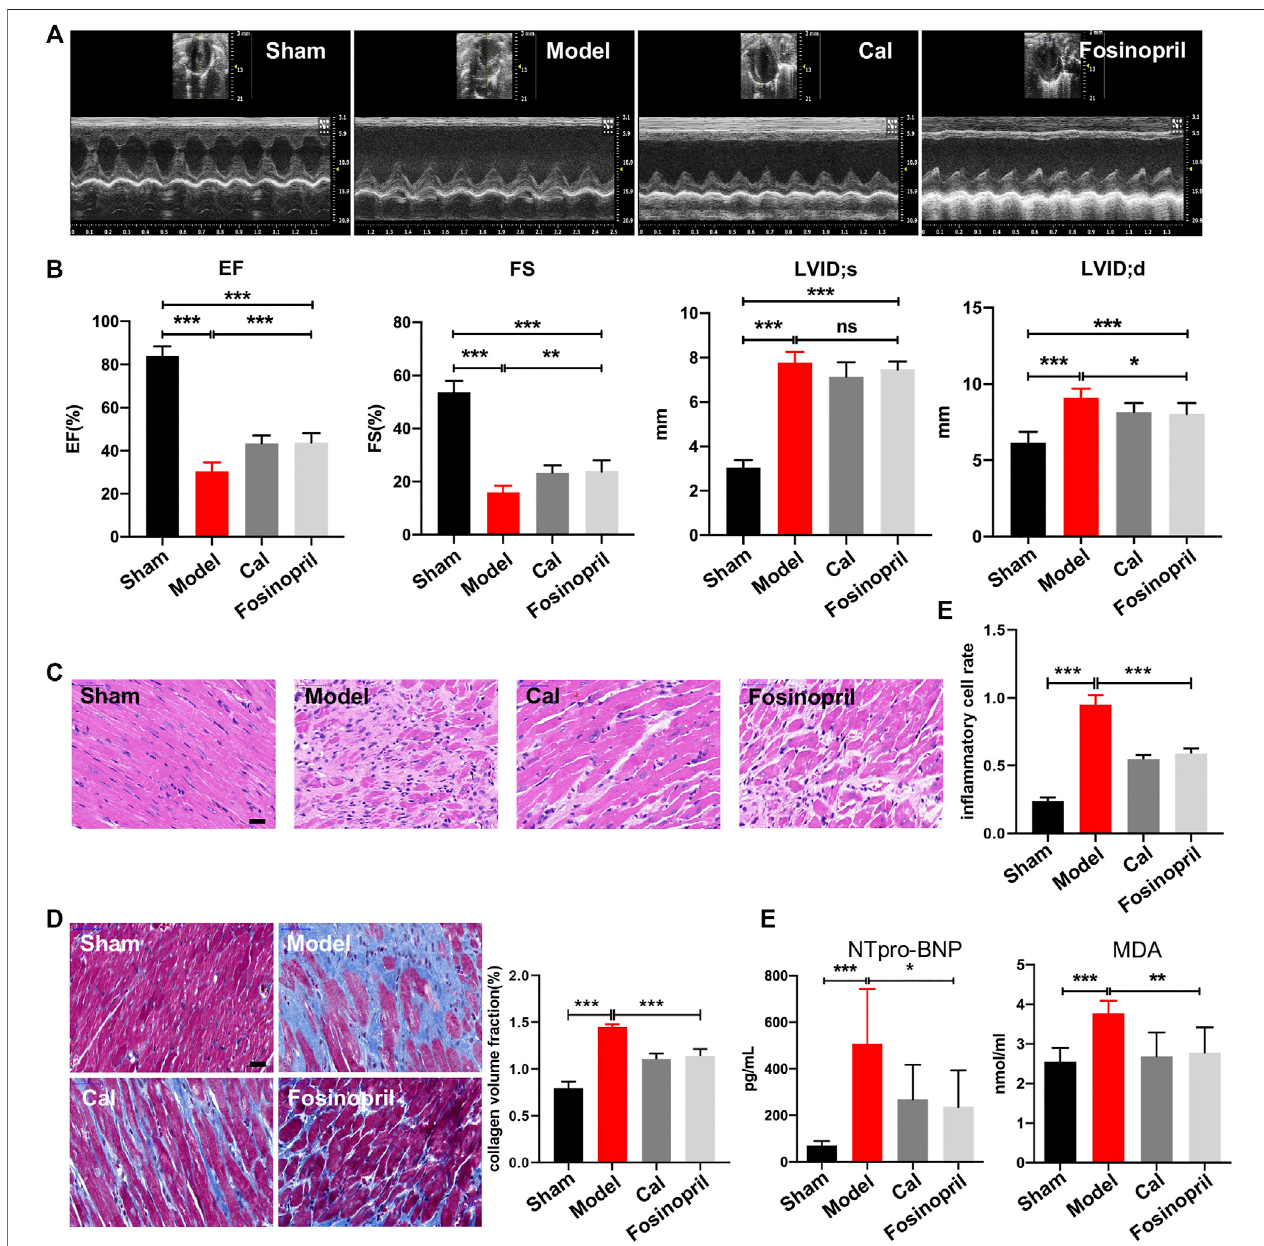
FIGURE 1 | Calycosin (Cal) protected heart function against heart failure (HF) in rats. (A) Representative images of echocardiography representing the changes in cardiac function. (B) Echocardiographic analysis showed that Cal and fosinopril treatment could increase ejection fraction (EF) and fractional shortening (FS), and decrease left ventricle internal dimension — diastole (LVID; d) values, while there were no signi fi cances on left ventricle internal dimension — systole (LVID; s). (C) Hematoxylin – eosin (HE) staining showed that Cal and fosinopril treatment protected against the in fl ammation injury; scale bar = 50 μ m. Quanti fi cation of in fl ammatory cellin fi ltration (%)showedthatCaland fosinopriltreatmentdecreasedthein fl ammatorycellrate. (D) Massonstainingand quanti fi cationofcollagenvolume fraction (CVF) showed that Cal and fosinopril treatment reduced collagen deposition and alleviated myocardial fi brosis; scale bar = 50 μ m. (E) Levels of serum NTpro- BNPand MDA in thedifferentgroups. Data arepresented asthe mean ± standard error ofthree independent experiments ( N = 8 per group, * p < 0.05, ** p < 0.01, and *** p < 0.001).